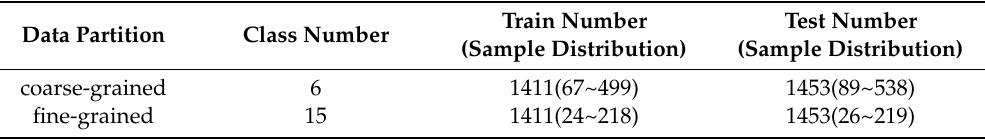
Table 2. Distribution of data